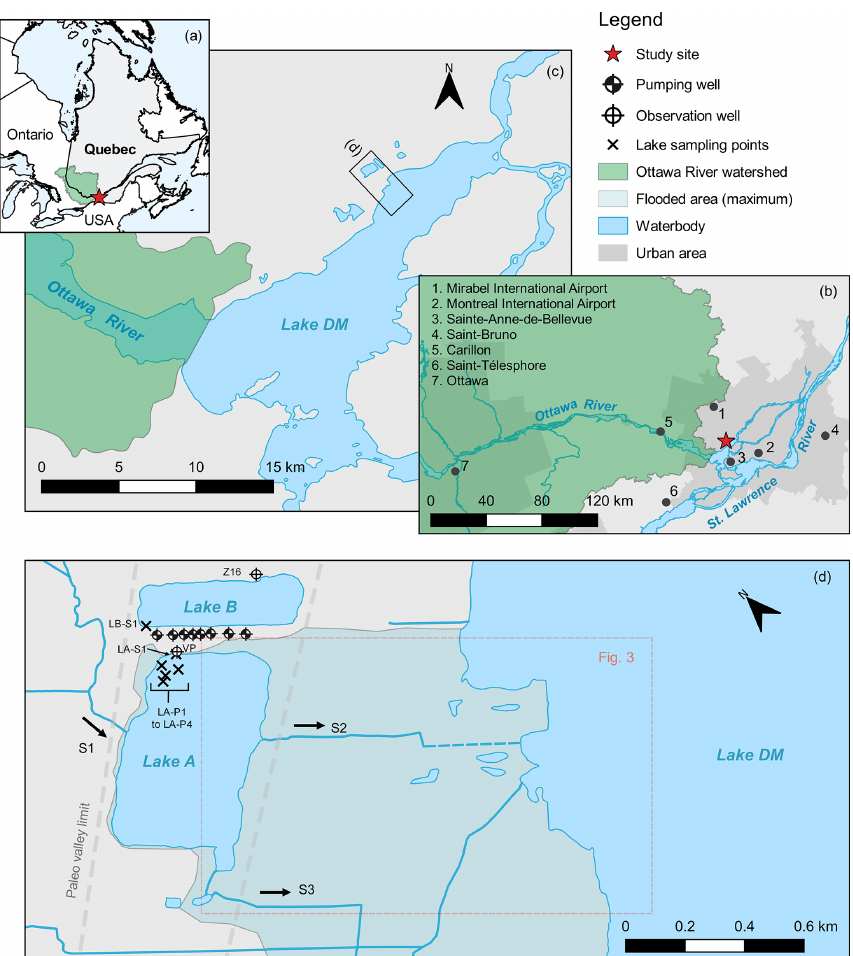
Figure 1. (a–c) Location of the study site, relative to the Ottawa River watershed, lake Deux Montagnes (DM), and the area of Greater Montreal. (d) Location of lake A and lake B relative to lake DM and a schematic representation of the hydrogeological context. The grey dashed lines illustrate the approximative extent of the paleo valley. LA-S1 and LB-S1 are surface water sampling points at lake A and lake B, respectively. LA-P1 to LA-P4 correspond to vertical profile sampling locations at lake A. The maps were created from openly available data and used in accordance with the Open Government Licence – Canada, or the Open Data Policy, M-13-13 of the United States Census Bureau. Detailed source information is provided in Appendix